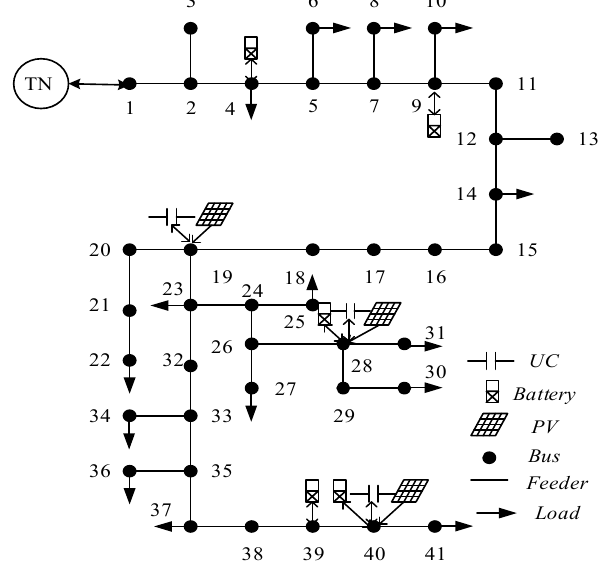
Figure 4. Flowchart of implementation of the method.